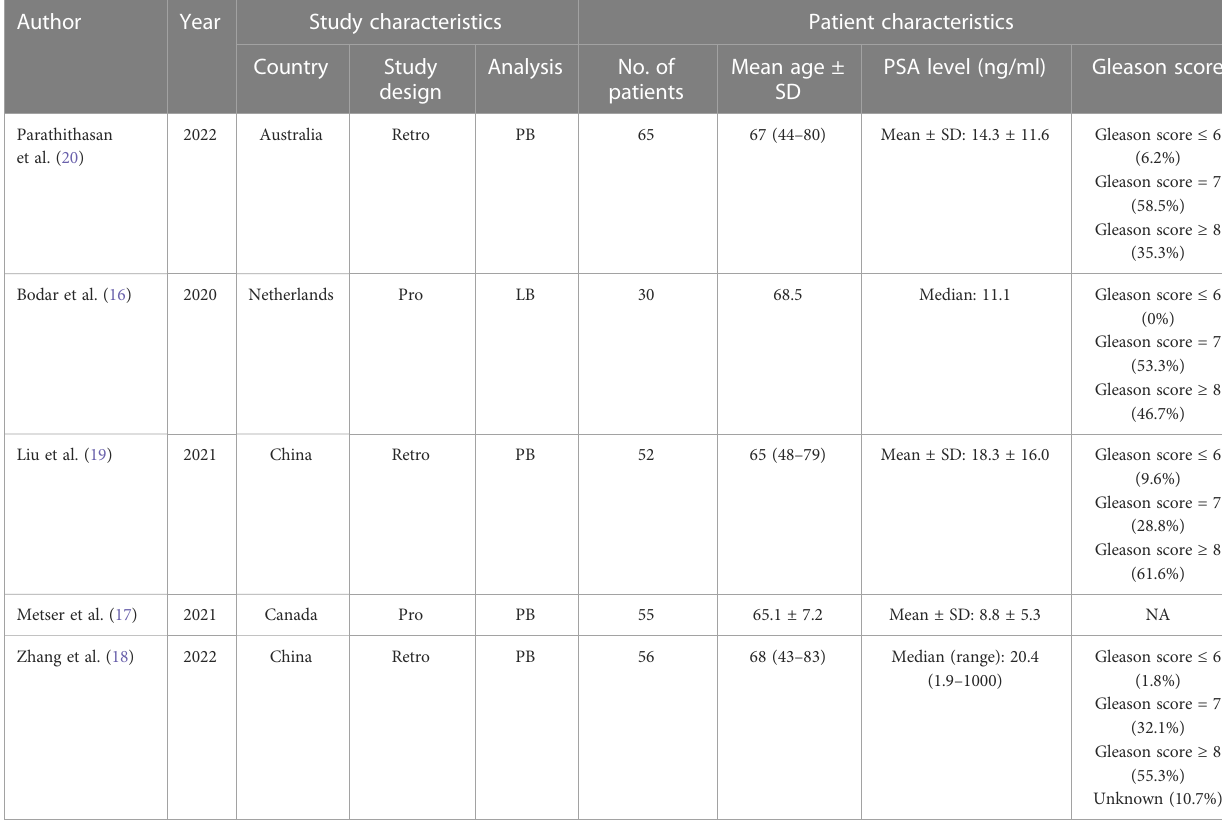
TABLE 1 Study and patient characteristics of the included studies.